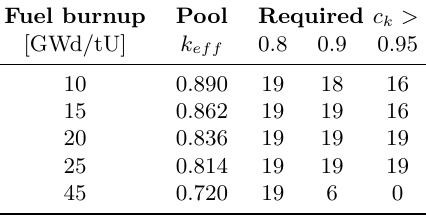
Table 1. Amounts of reactor criticals with c ilarity higher than 0.8, 0.9 and 0.95 to pool storage systems in various levels of burnup.